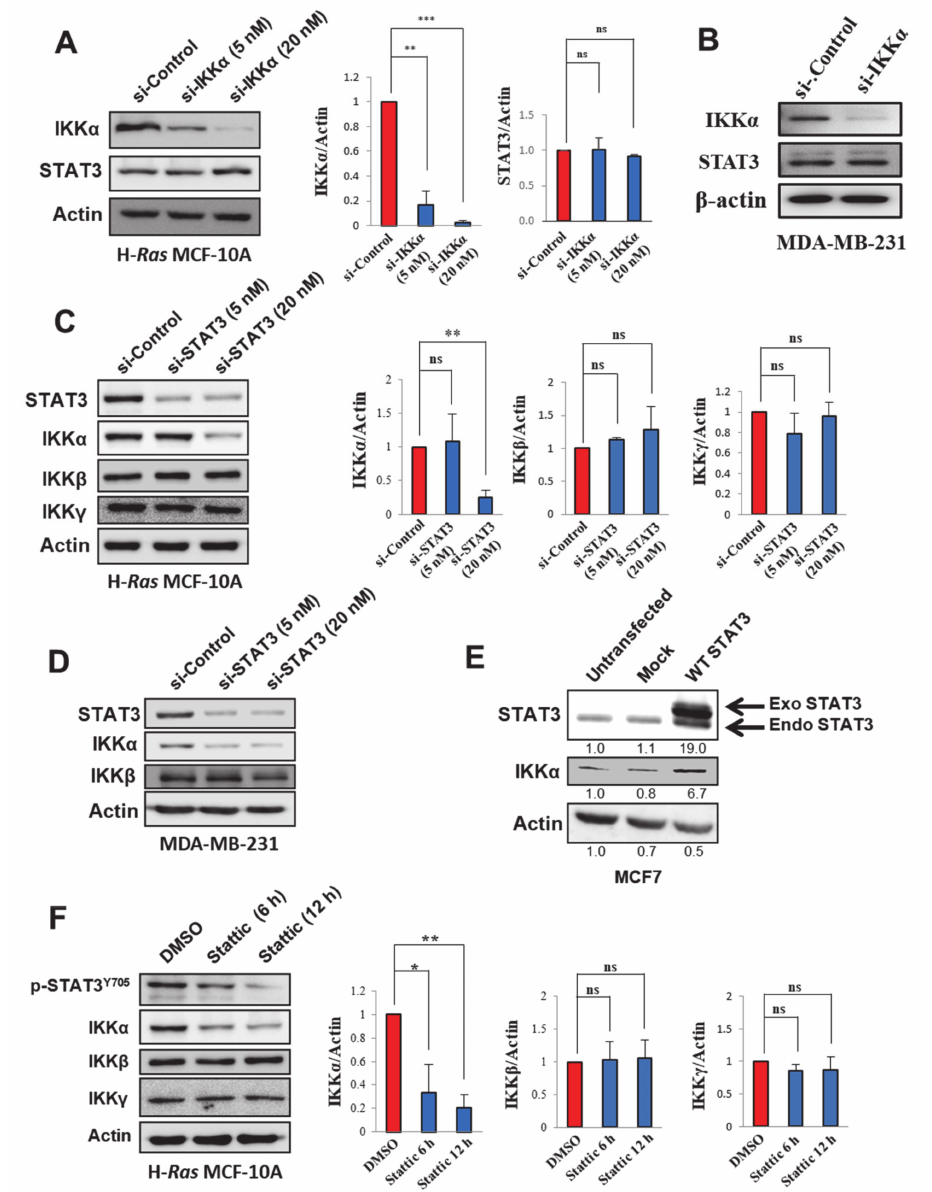
Figure 3. STAT3-dependent expression of IKK α in human breast cancer cell lines. ( A , B ) Immunoblot analysis of IKK α and STAT3 in H- Ras MCF-10A ( A ) and MDA-MB-231 ( B ). Cells were transfected with si-Control or si-IKK α for 48 h, and expression of STAT3 was measured by immunoblot analysis. Actin, a loading control for immunoblotting. For Figure 3A, the band intensities were normalized by the actin level and presented as bar graphs. ns, not significant; ** p < 0.01; *** p < 0.001 ( n = 3). ( C , D ) Immunoblot analysis of STAT3, IKK α , IKK β , and/or IKK γ expression levels in H- Ras MCF-10A ( C ) and MDA-MB-231 ( D ) cells transfected with si-Control or si-STAT3 (5 and 20 nM) for 48 h. For Figure 3C, the band intensities were normalized by the actin level and presented as bar graphs. ns, not significant; ** p < 0.01 ( n = 3). ( E ) Immunoblot analysis of IKK α and STAT3 in MCF7 cells transfected with mock or STAT3-overexpressing vectors. ( F ) The H- Ras MCF-10A cells were treated with Stattic (1 µ M) for 6 or 12 h. The expression levels of p-STAT3, IKK α , IKK β , and IKK γ were assessed by immunoblot analysis. The band intensities were normalized by the actin level and presented as bar graphs. ns, not significant; * p < 0.05; ** p < 0.01 ( n =